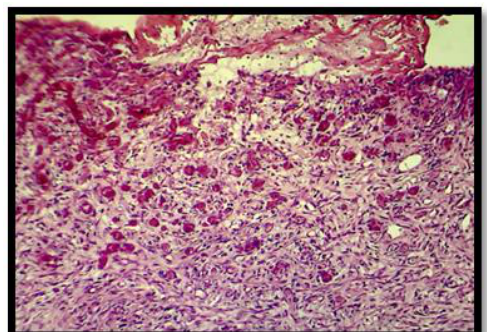
Figure, 6: BP-treatment group at 8th week post implantation shows fragments of pericardial implant (long arrow) and high vascularization, presence of immature collagen fibers and blood vesesles in the host tissue(short arrow) (Mallory stain, 200X).